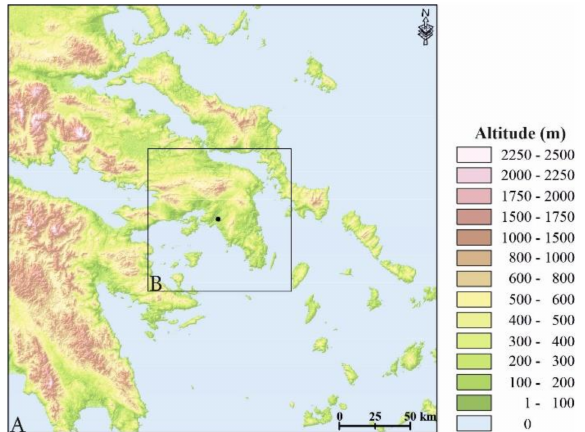
Figure 2. Configuration of nested grids. The outer frame ( A ) indicates the coarse grid (300 × 300 km 2 ), whereas the inner frame ( B ) indicates the fine grid (100 × 100 km 2 ). The bullet presents the center of both domains (Latitude 37 o 58 (cid:48) 4” N, Longitude 23 o 44 (cid:48) 10” E), 15 m above sea